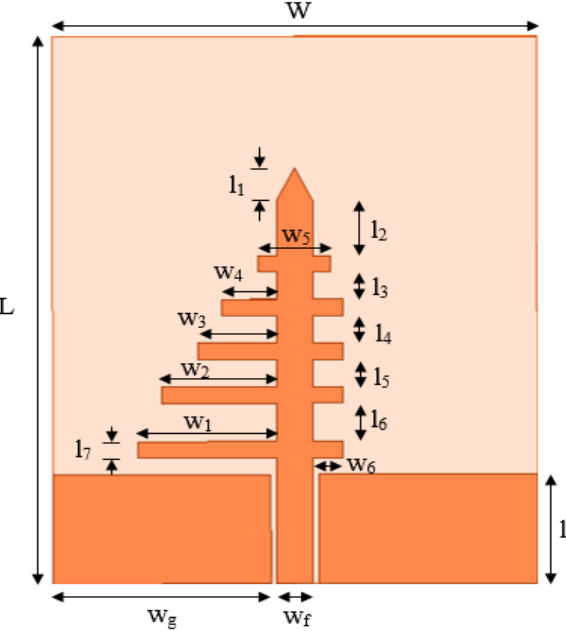
Figure 1. Geometry of proposed PLPA.